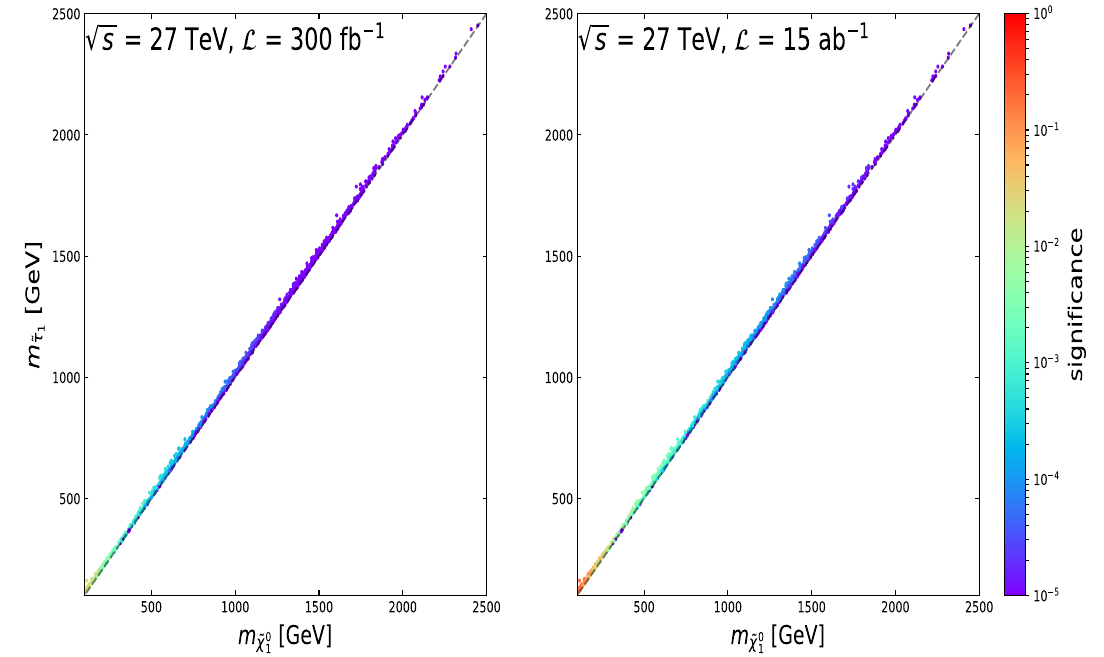
→ j + τ + E miss at the h T 1